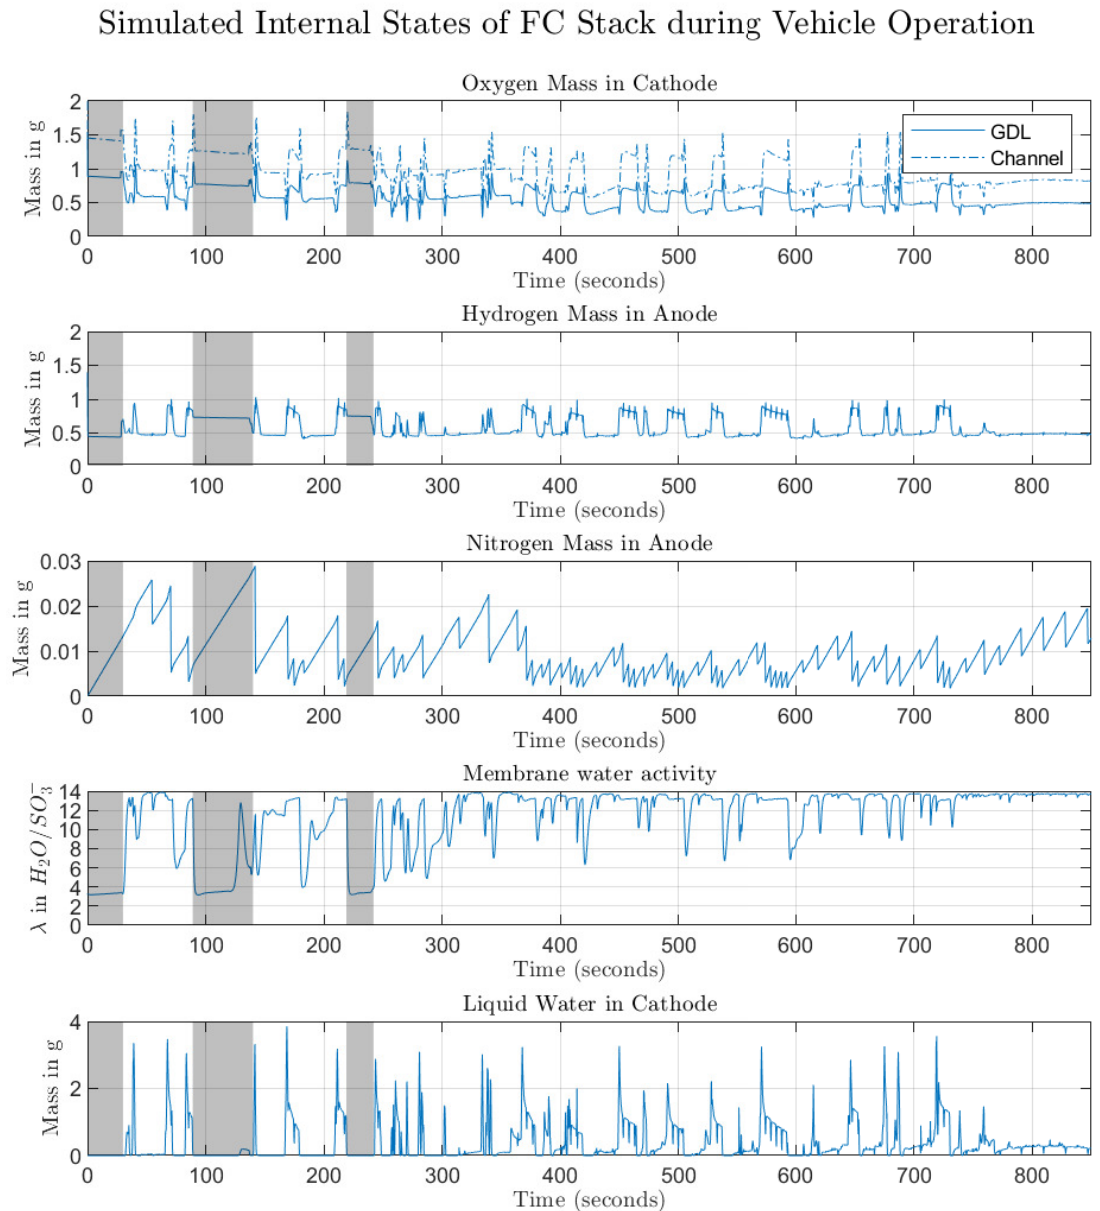
Figure 6. Internal states of the fuel cell stack as determined by the system